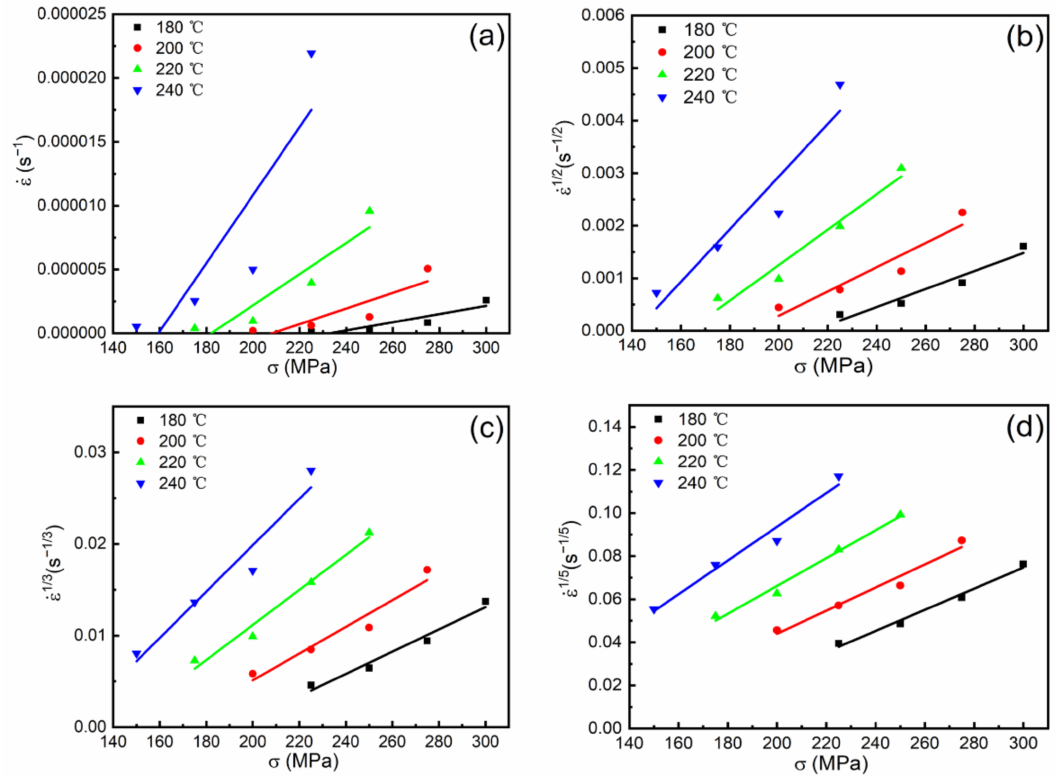
. Figure 8. Plots of ε 1/ n versus σ for ( a ) n = 1, ( b ) n = 2, ( c ) n = 3, and ( d ) n = 5 on linear scales for the alloy with 6.00 wt % Cu.